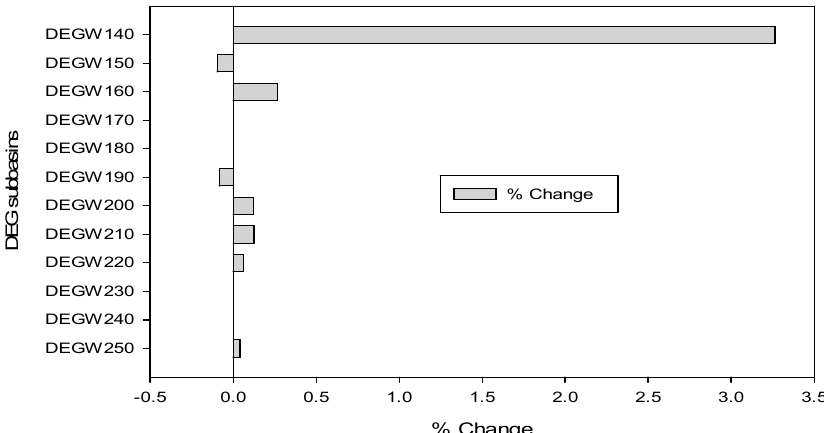
Figure 5. Sub-basin peak flow response to the Phase 1 alternative in the Degema Basin. Changes in the right direction represent negative changes. It shows changes in DEG 140 were higher than changes in other sub-basins in the Degema Basin.